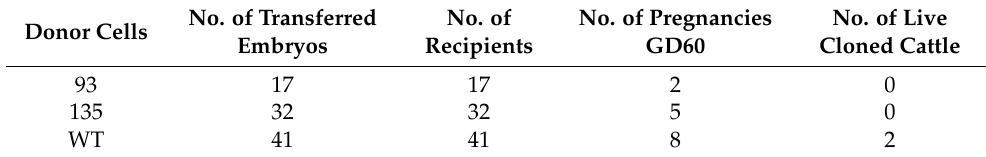
Table 2. In vivo development of NT embryos derived from single-cell clones 93 and 135. Donor Cells